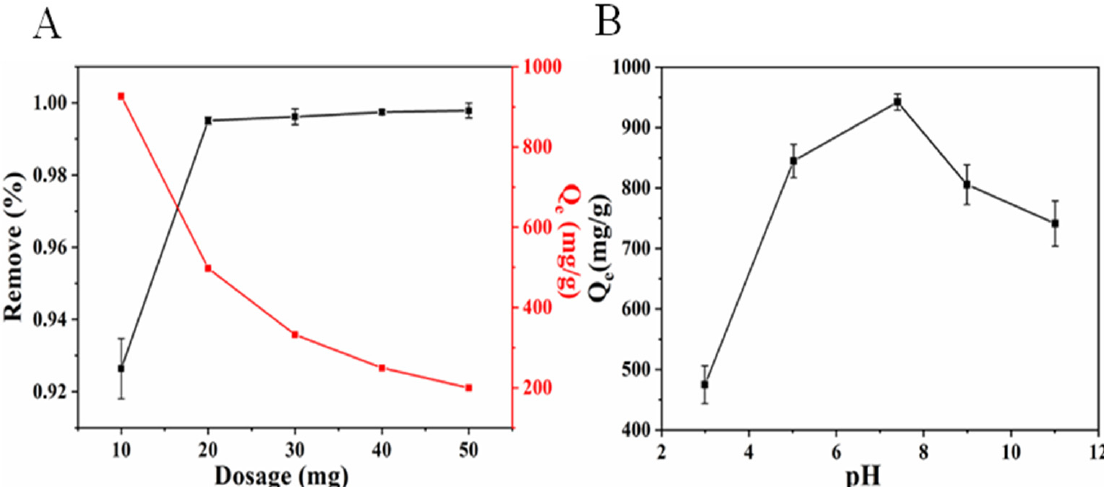
Figure 3. Effect of N-doped CM-chitin dosages on the adsorption capability toward CR (200 mg L − 1 ) ( A ), and effect of pH on the N-doped CM-chitin adsorption capability toward CR (200 mg L − 1 ) ( B ).